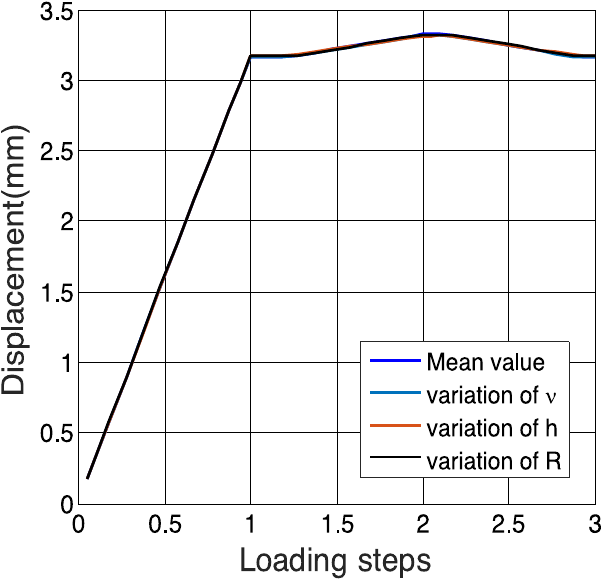
Fig. 8. Variables with non in fl uence in the